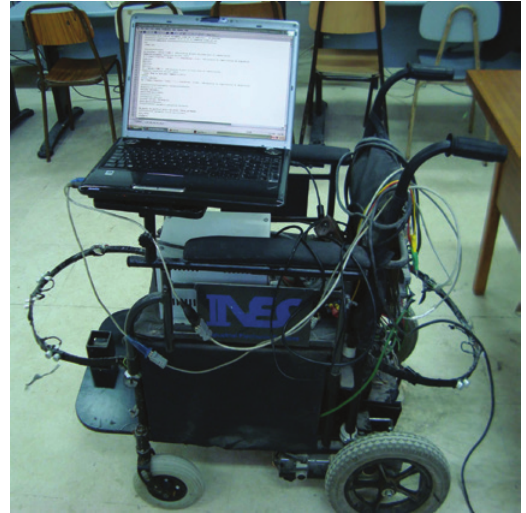
Figure 1: Standard Electric Wheelchair with Control